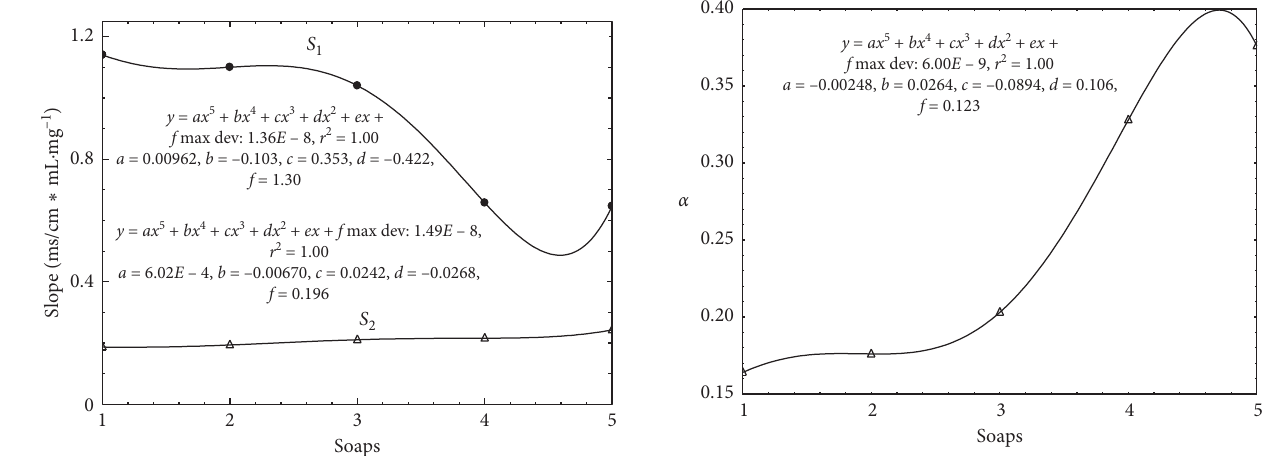
Figure 3: Variation of slope versus soaps in premicellar slope ( S and postmicellar slope ( S 2 ) regions.